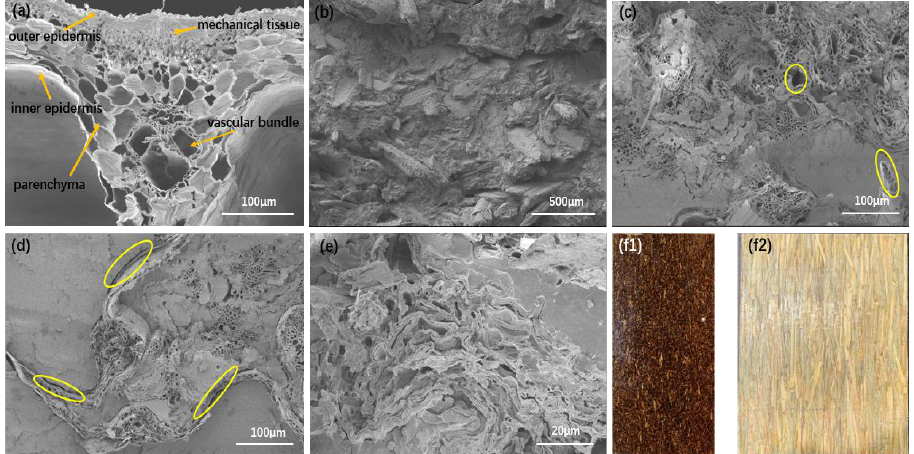
Figure 6. Structure of the straw and straw/LLDPE composite: cross-section of straw stalk ( a ), extruded straw particle composite ( b ), hot-pressed untreated straw composite ( c ), hot-pressed ground straw composite ( d ), hot-pressed slope-cut straw composite ( e ), and appearance of extruded straw particle composite ( f1 ) and hot-pressed straw composite ( f2 ).